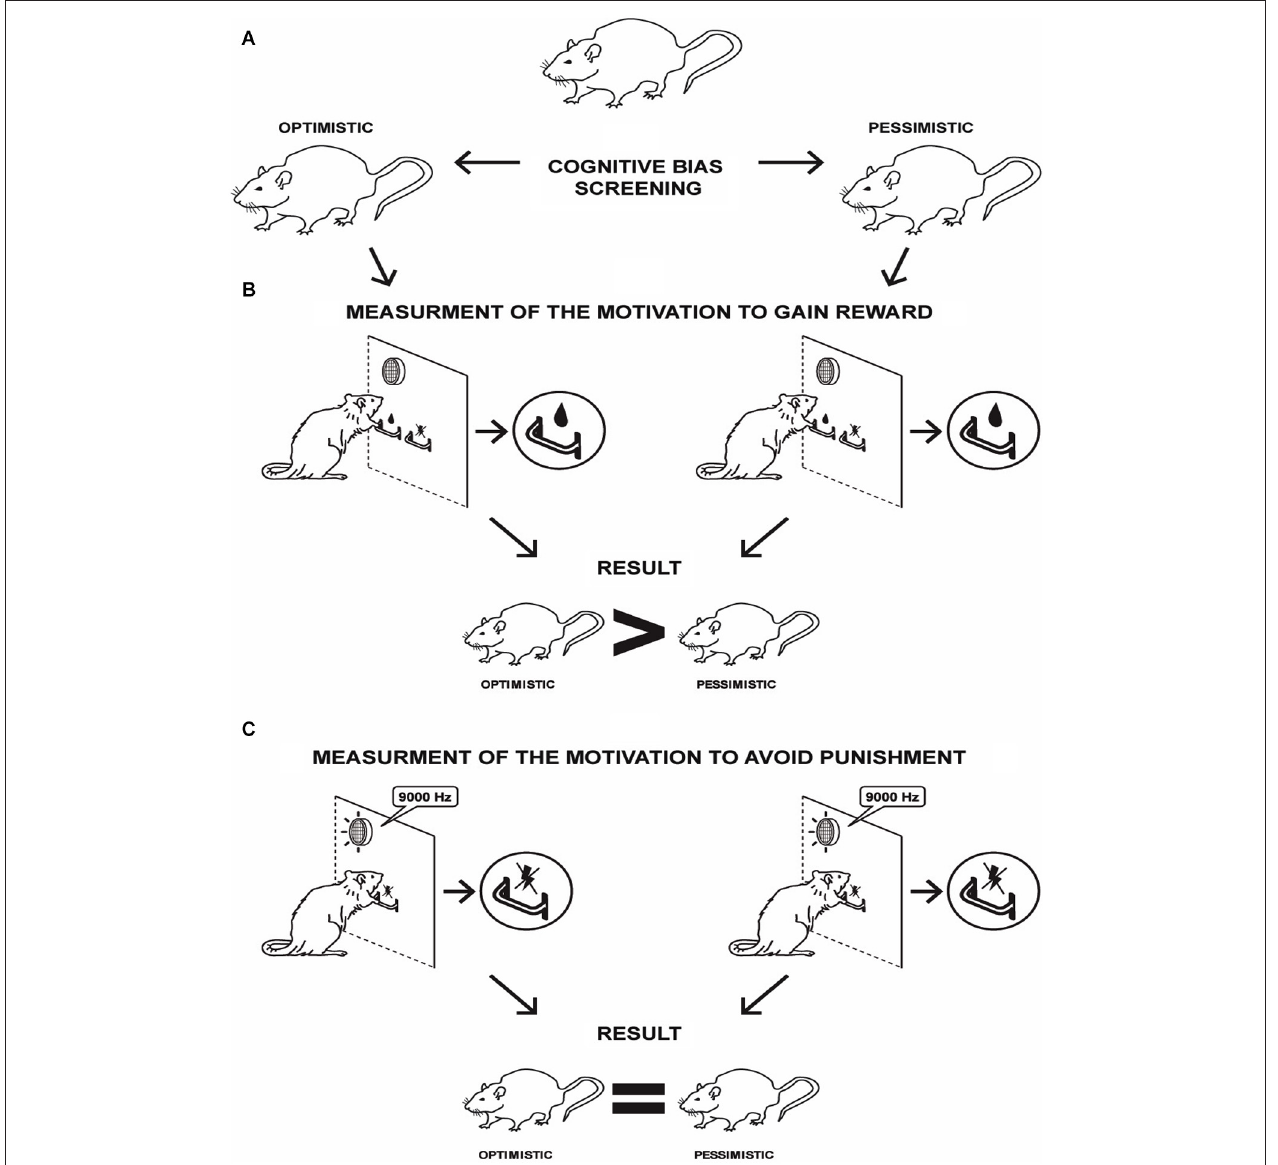
reward. On the progressive ratio (PR) schedule of reinforcement, “optimism” has been associated with a significantly higher motivation to gain reward than “pessimism”. (C) Measurement of motivation to avoid punishment. No significant differences were observed in the motivation to avoid punishment between the “optimistic” and “pessimistic”